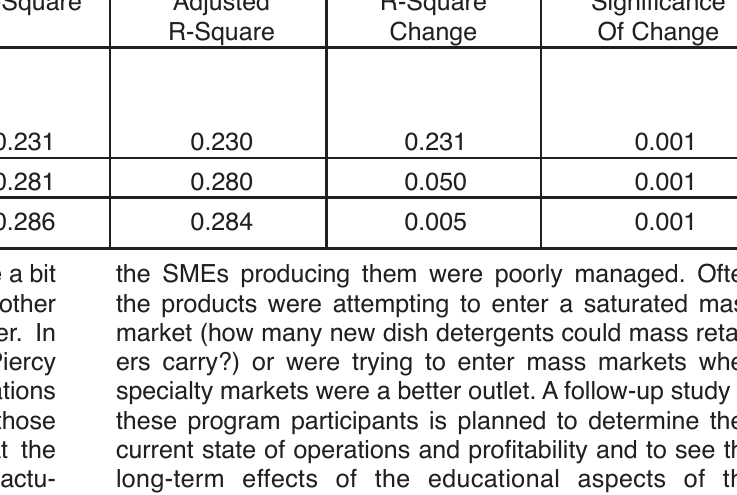
Regression Analysis—Prediction of Forwarded Status Independent